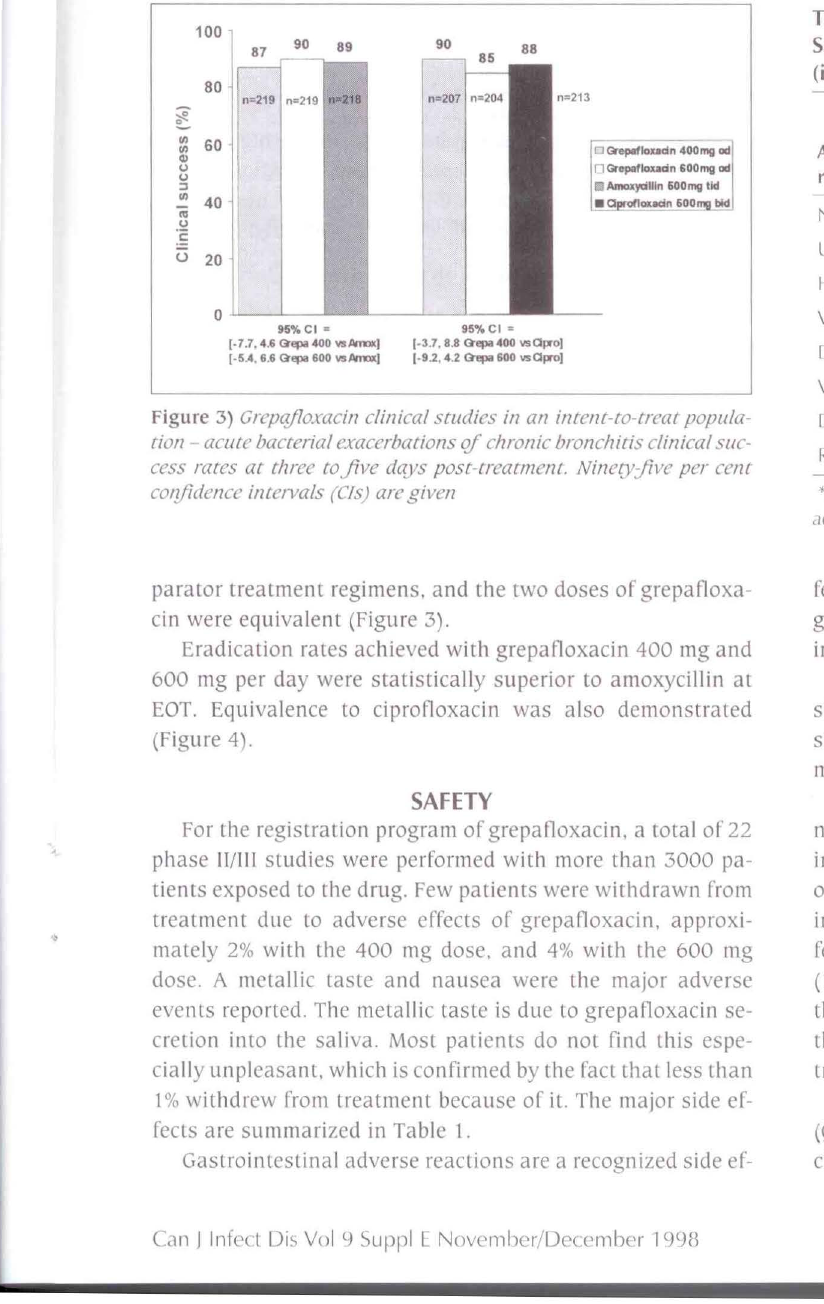
Safety: Most common adverse effects of grepafloxacin (incidence of 5% or greater) ob erved in multiple dose studies Grepafloxacin